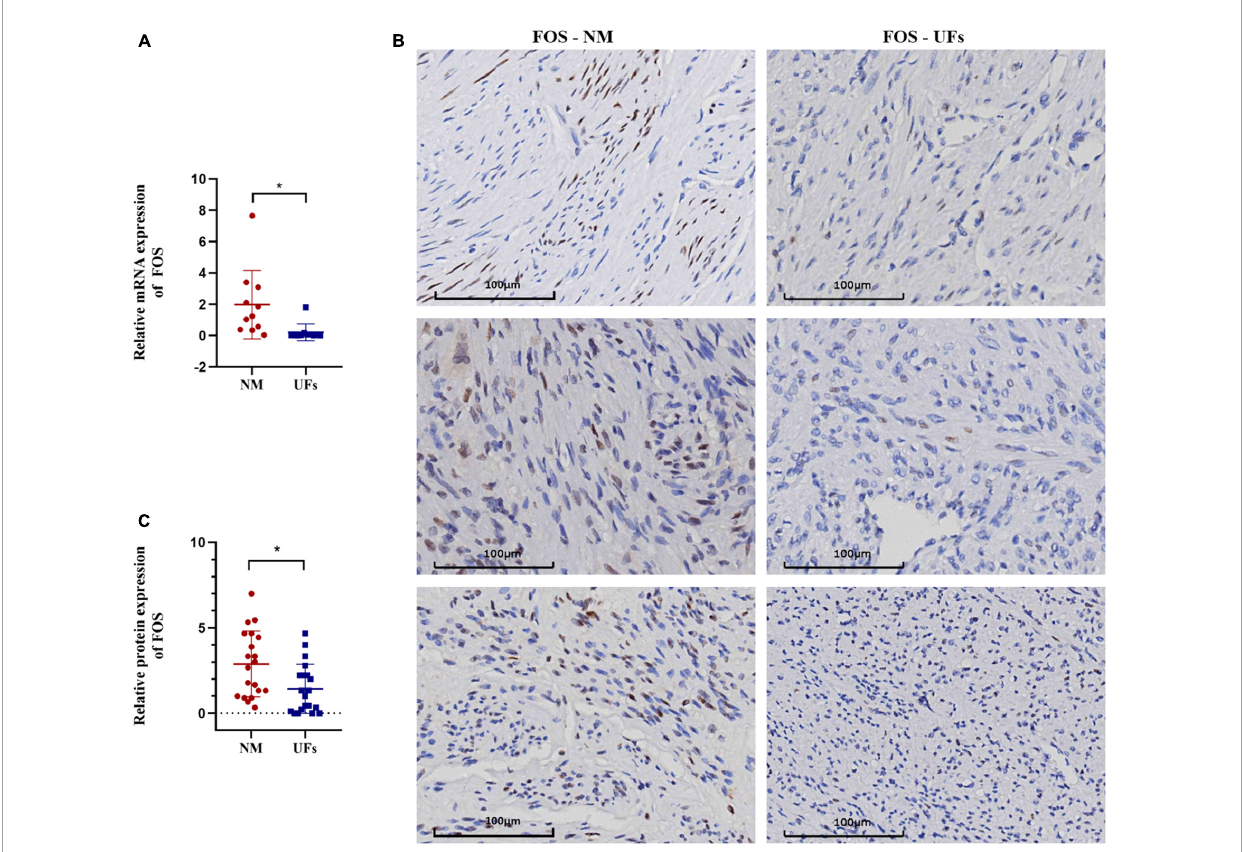
FIGURE5 The expression of FOC in fibroid and normal myometrium tissue. (A) The relative expression of FOS in the mRNA level. (B) Immunohistochemical results of typical samples from two groups, all images were presented at 20-X. (C) IHC score. NM, normal myometrium, UFs, uterine fibroids. * P <